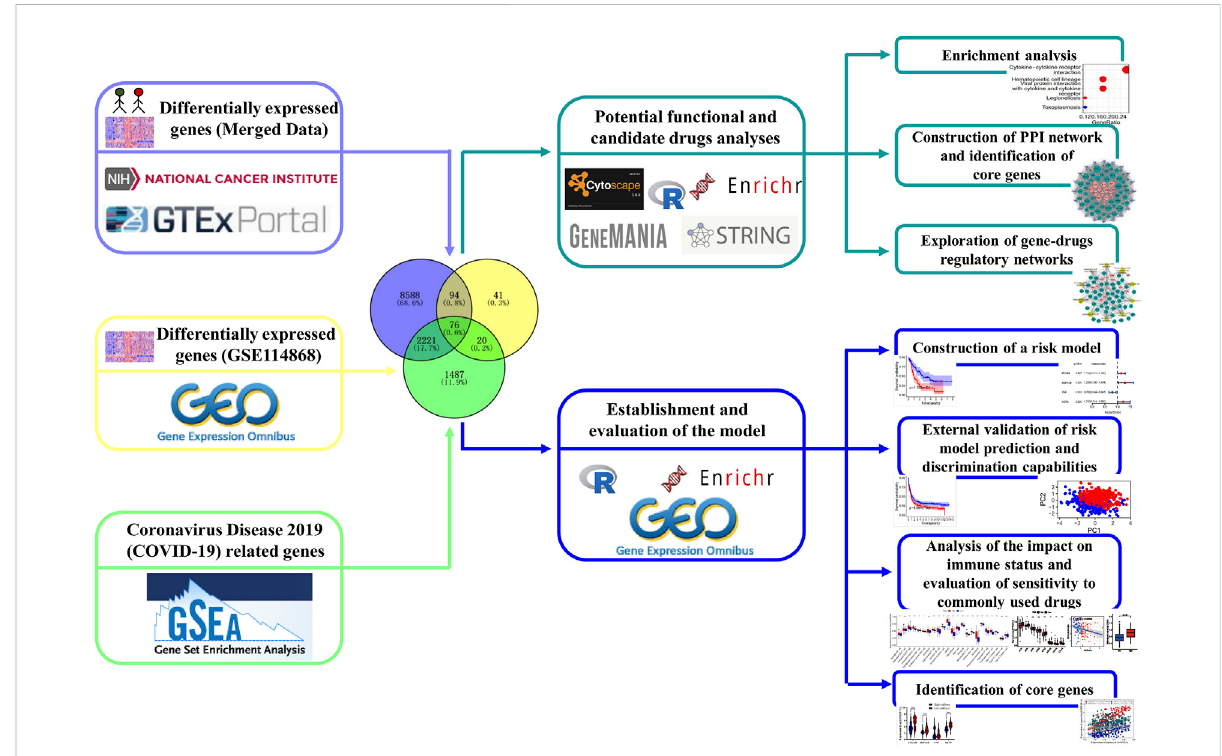
FIGURE 1 Flow diagram exhibiting the process analysis of the